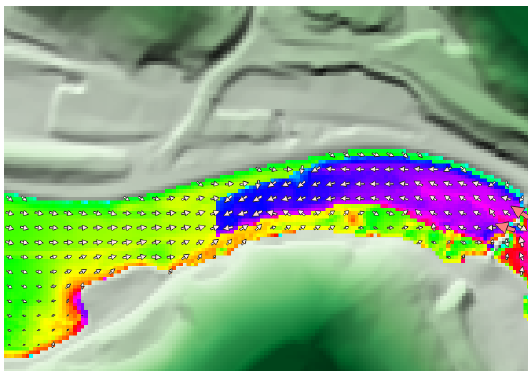
Figure 4. Actual simulation error detected by the proposed current stylization